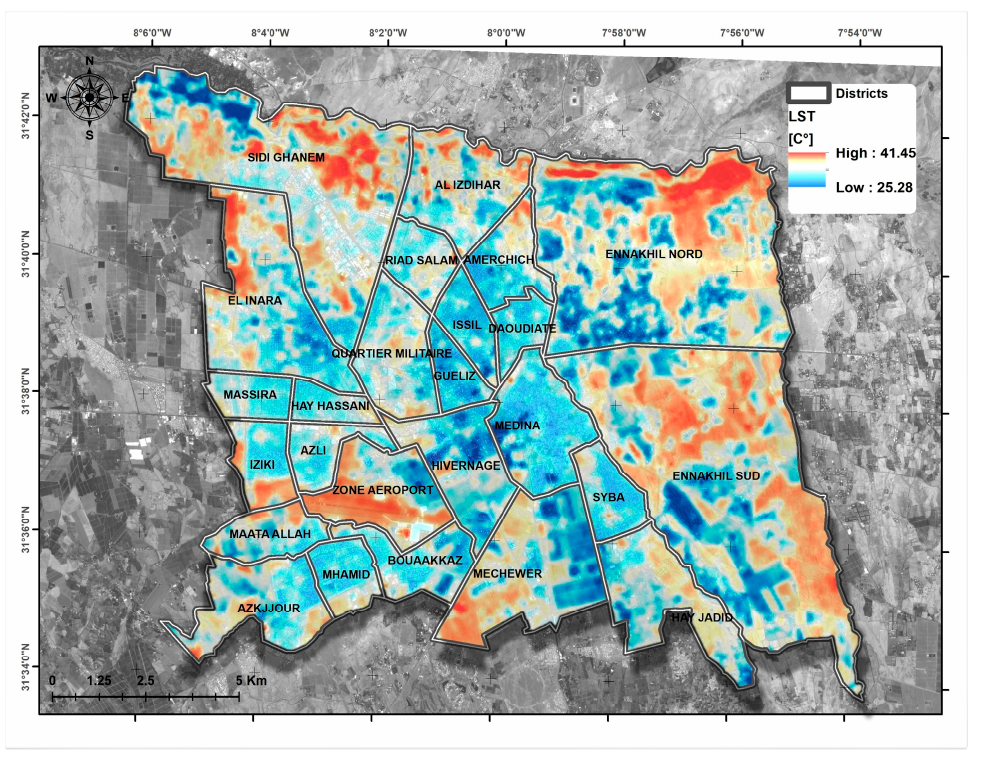
Figure 4. Spatial variation in land surface temperature.